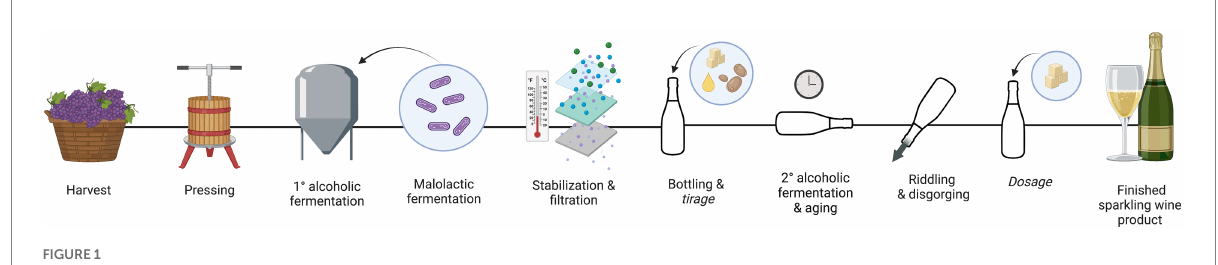
FIGURE 1 Method for traditional method sparkling wine